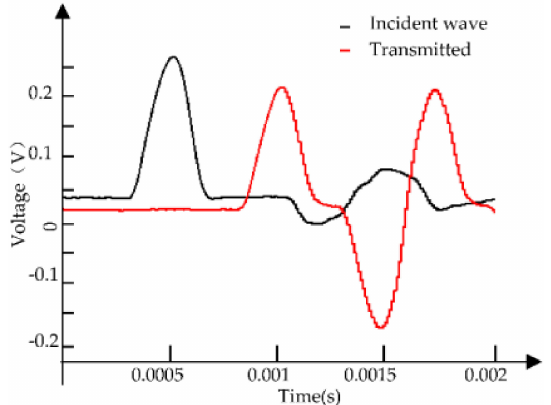
Figure 5. Typical waveform of rock specimen under dynamic